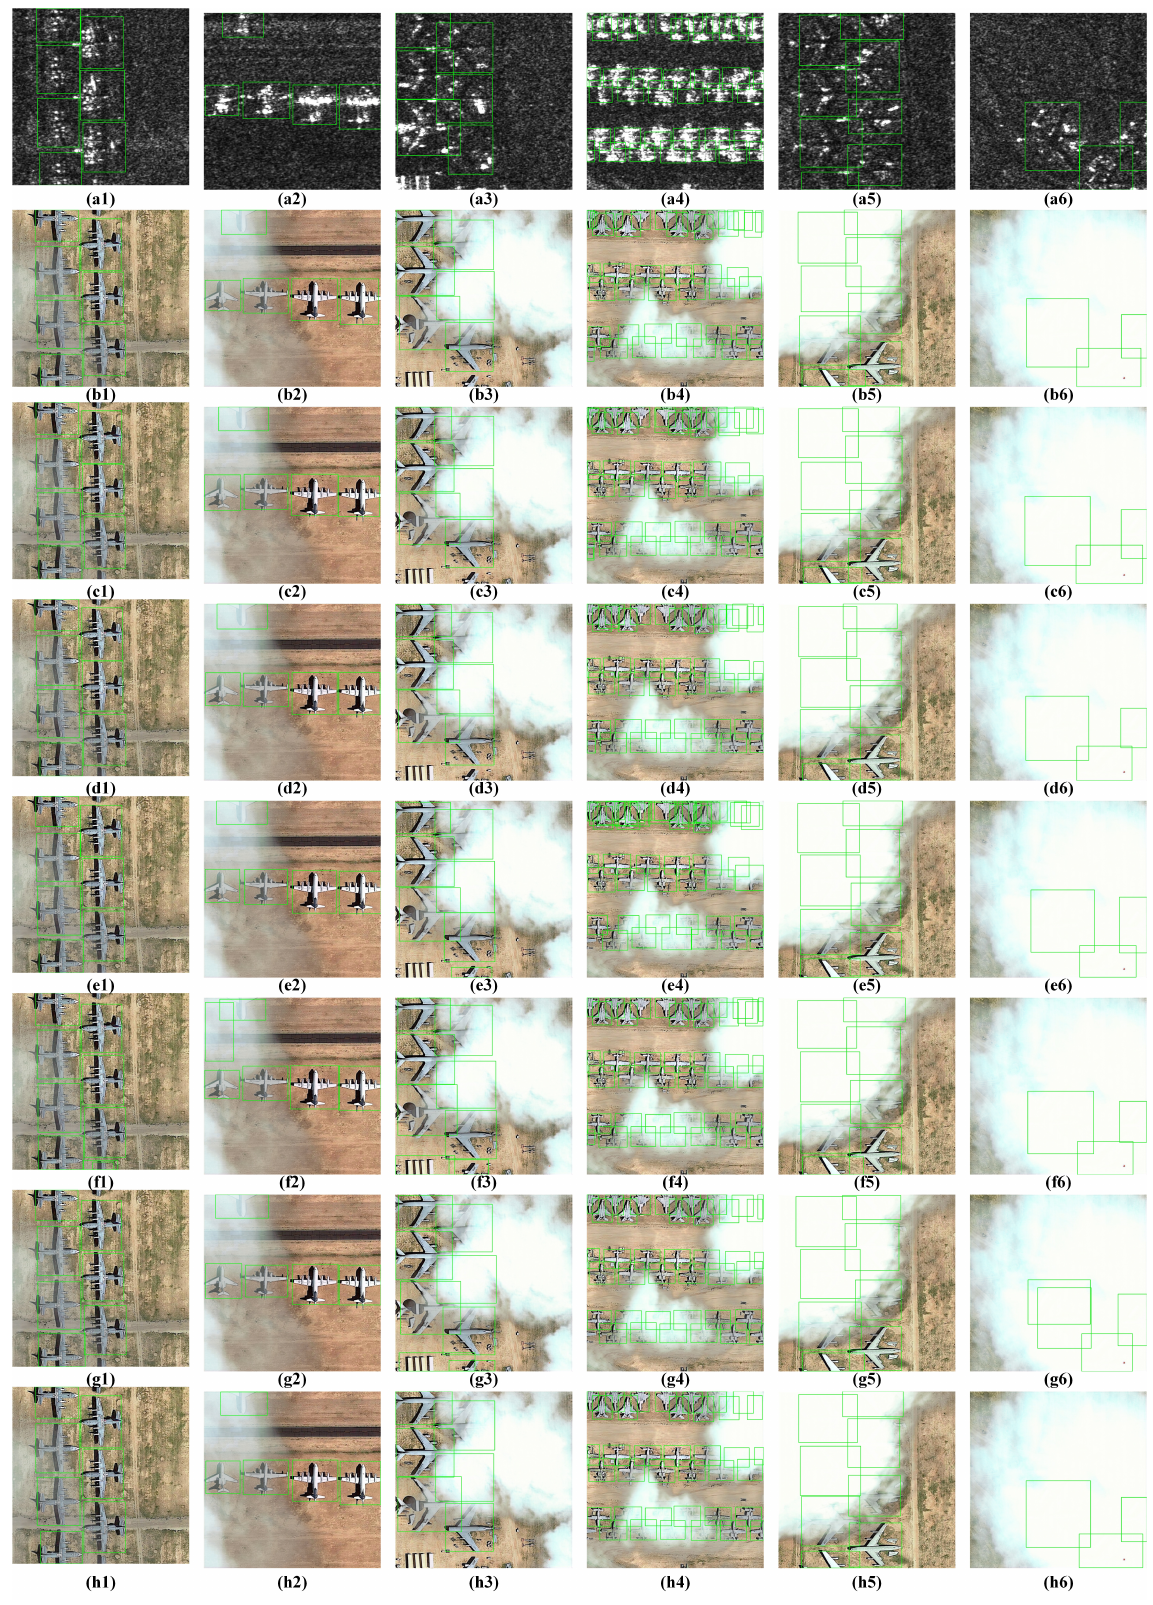
Figure 11. Visual comparison of different fusion models. ( a1 – a6 ) GT. ( b1 – b6 ) Sum Fusion. ( c1 – c6 ) Max Fusion. ( d1 – d6 ) Concat Fusion. ( e1 – e6 ) MCFF. ( f1 – f6 ) CIAN. ( g1 – g6 ) SM Fusion. ( h1 – h6 )